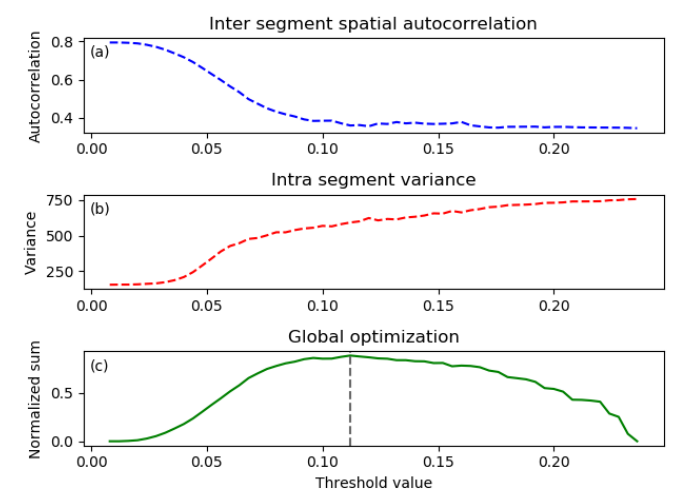
Figure 3. Unsupervised parameter optimization. Graph ( a ) shows decrease in spatial autocorrelation between clusters as the threshold increases. Graph ( b ) shows an increase in variance within clusters as the threshold increases. The normalized combination of the two appears in graph ( c ), with the optimal threshold indicated by the vertical dotted line. These graphs were derived from the unsupervised parameter optimization (USPO) procedure in the Shizaf study